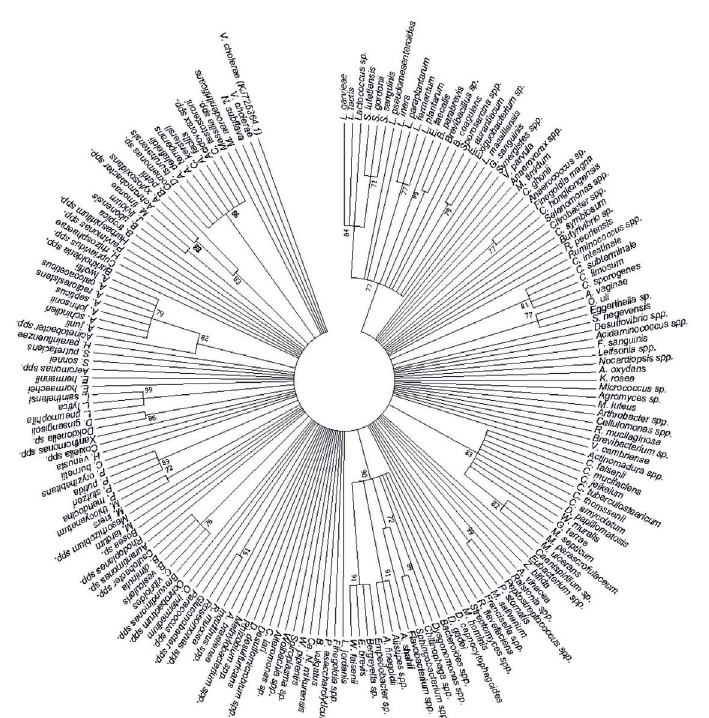
Fig. 4. The phylogenetic tree depicts the detected human bacterial pathogens by using the Maximum Likelihood method based on the Tamura-Nei model on 182 nucleotide sequences and 70% bootstrap.